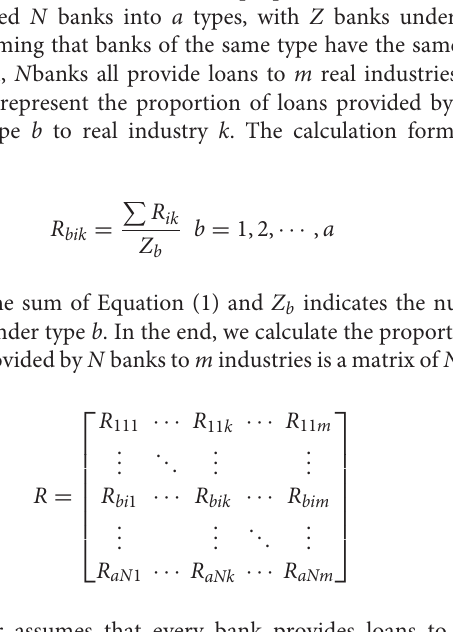
of bank balance sheet structure corresponding to Figure